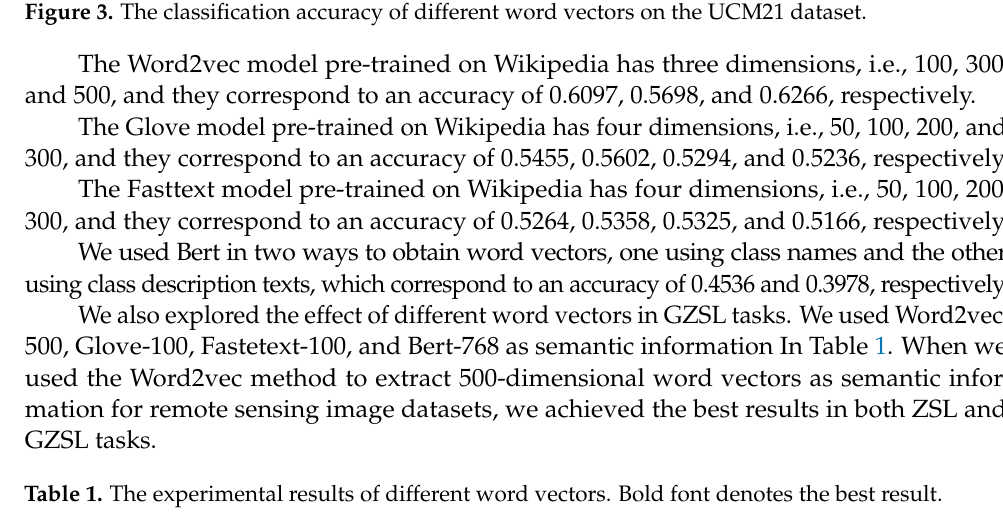
Table 1. The experimental results of different word vectors. Bold font denotes the best result.